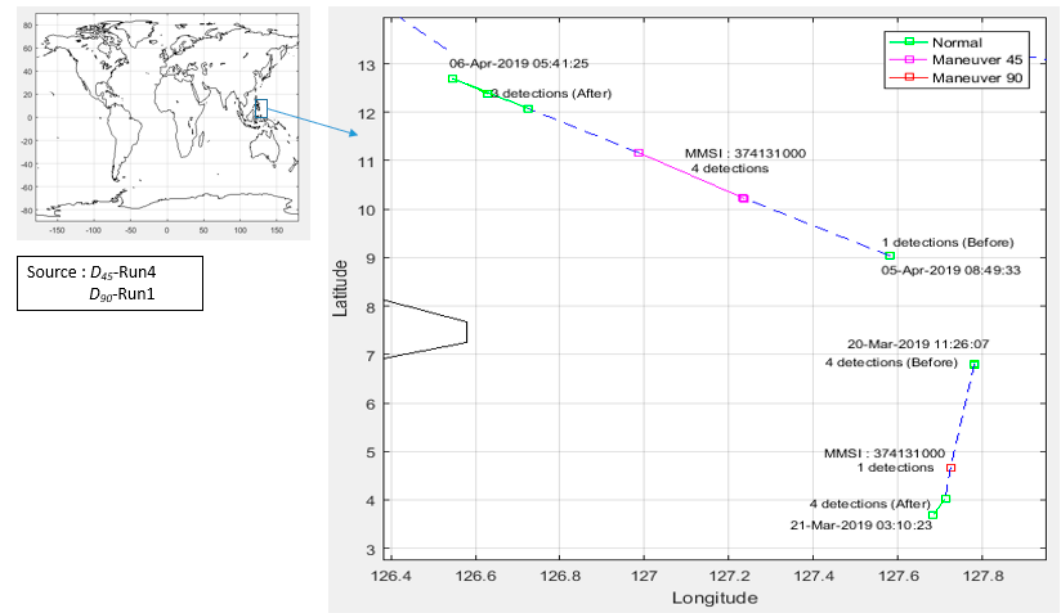
Figure 16. Class A sample of ship tracking in an area of 50–60% re-detection probability.